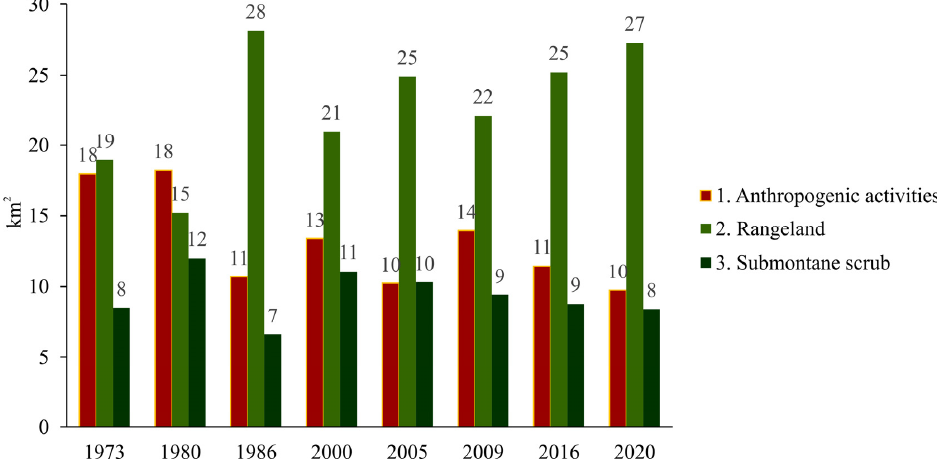
Figure 7. Land use coverage and changes in the study period, San Antonio, Jaumave, Tamaulipas, Mexico.